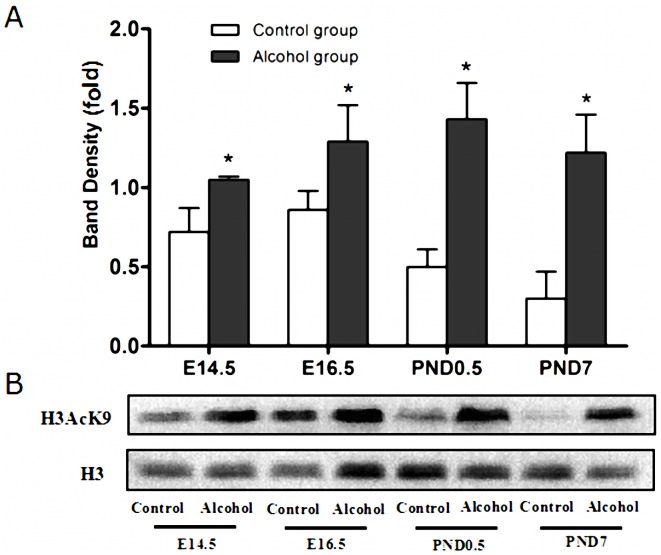
Histone H3K9 hyperacetylation induced by alcohol.According to the western blot analyses, the level of acetylation of histone H3K9 increased significantly after alcohol exposure with 5/kg on E14.5, E16.5, PND0.5 and PND7. *: P<0.05 vs. control group (n = 6). (A): statistic analysis, (B): band density. E14.5: embryo 14.5 day, E16.5: embryo 16.5 day, PND0.5: postnatal day 0.5, PND7: postnatal day 7.